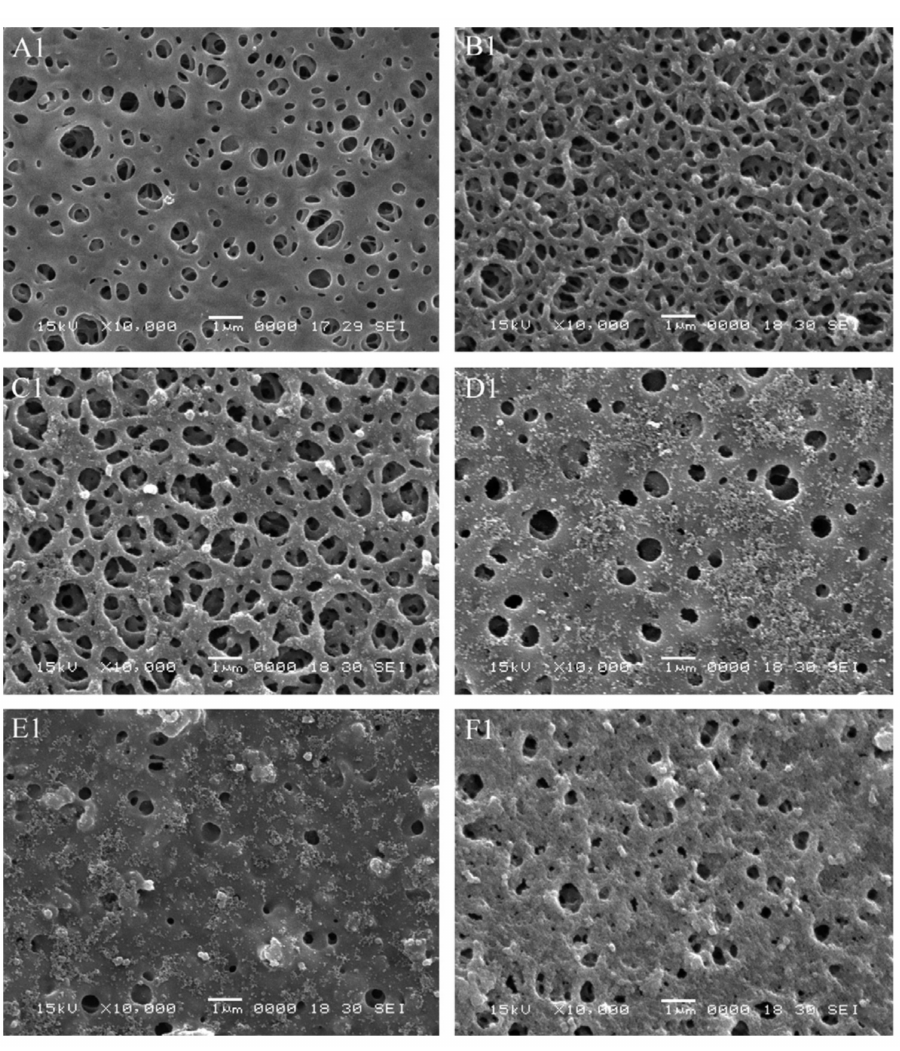
Figure 10. SEM images of the top surface morphology of the membranes with different TiO 2 content: ( A1 ) 0 wt.%, ( B1 ) 1 wt.%, ( C1 ) 2 wt.%, ( D1 ) 3 wt.%, ( E1 ) 4 wt.% and ( F1 ) 5 wt.%. Provided with permission from Elsevier